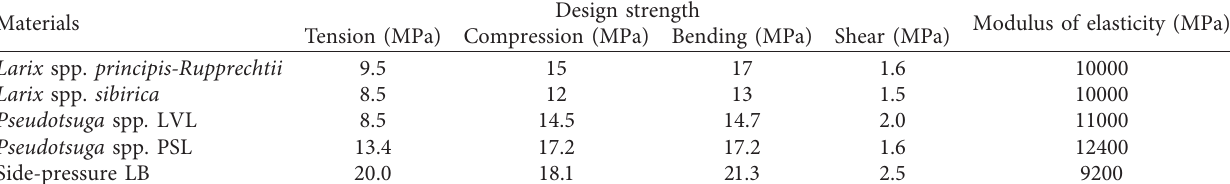
Table 3: Comparison of design strengths between side-pressure LB and structural materials.